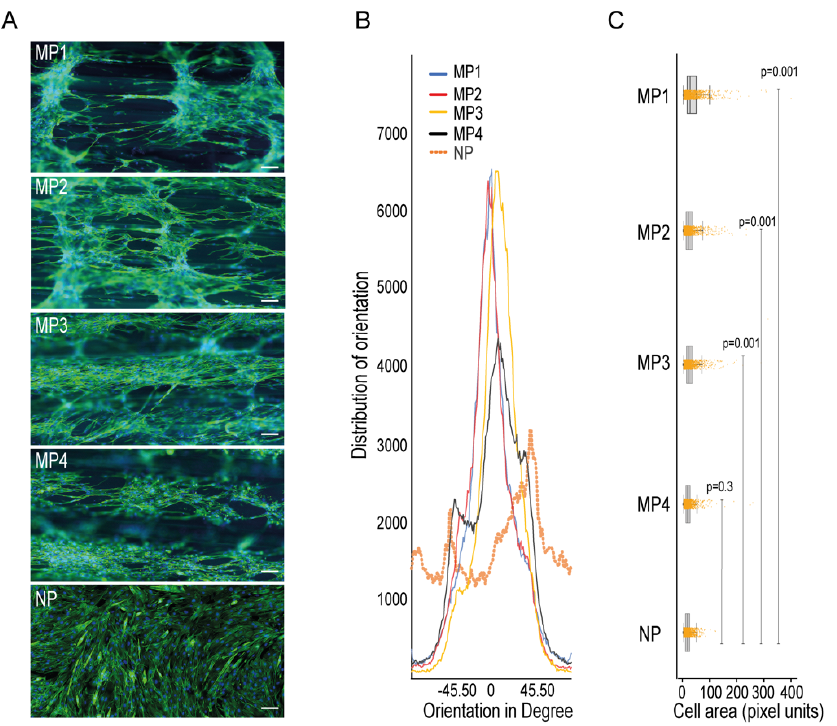
Figure 2. Impact of 3D-PMMD on cells orientation and morphology. ( A ) Cells were grown in microfluidic devices with different micropatterns as well as in conventional flat dishes. After the